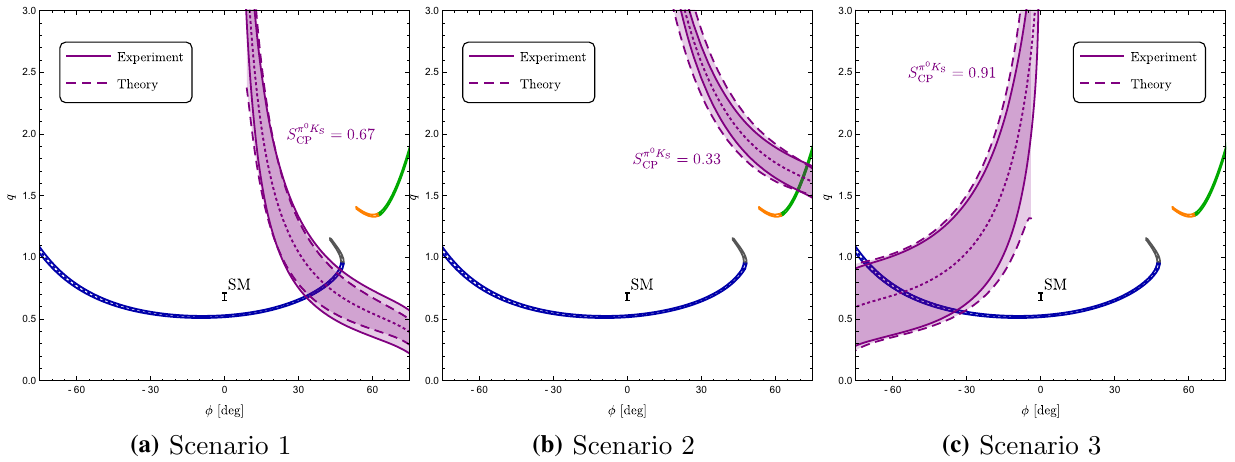
Fig. 14 Illustration of the future scenarios specified in Table 6. For the constraints following from measurements of S π 0 K S theory uncertainties are given separately